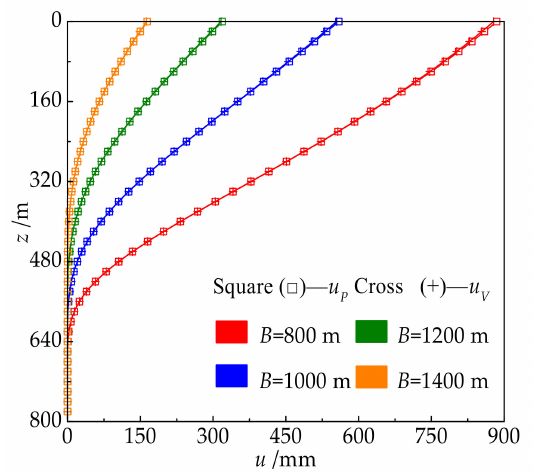
Figure 11. The shaft horizontal displacement curve ( n = 10).